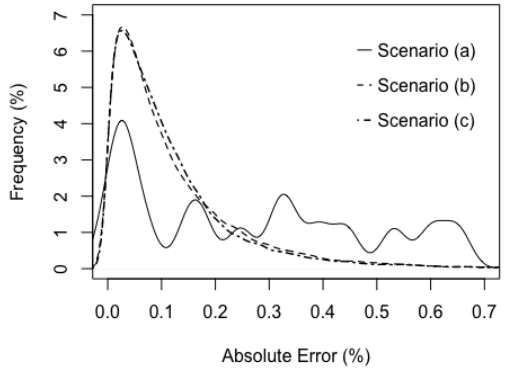
Figure 3. Case study 1: Distribution of wind power forecasting errors in scenarios ( a ) – ( c ).